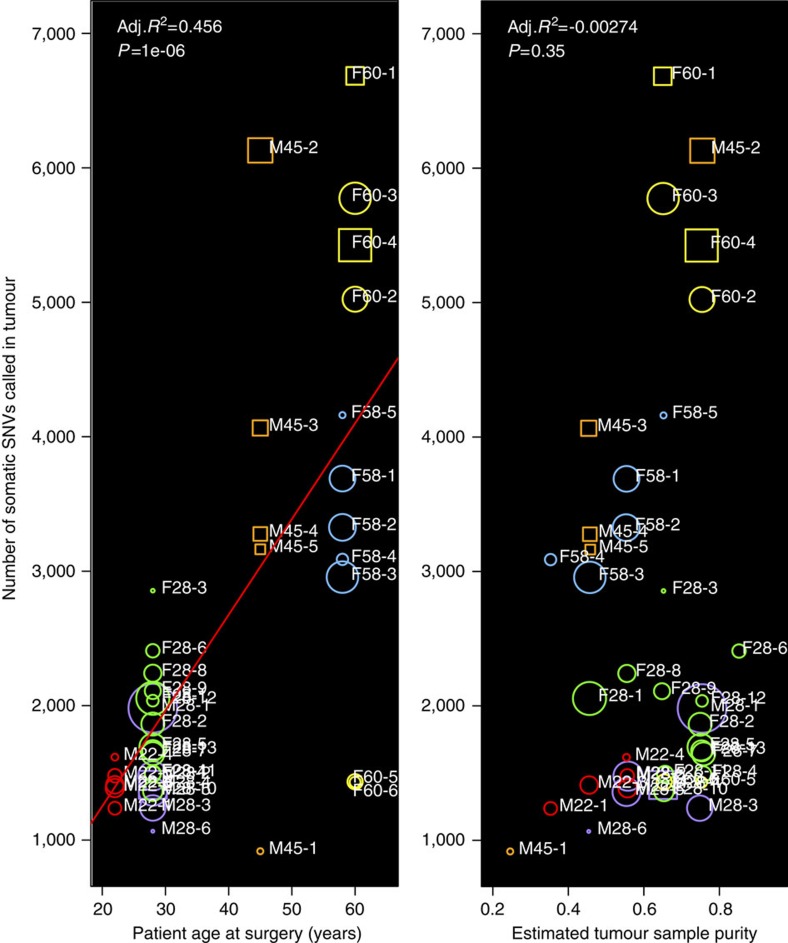
The number of somatic SNVs per tumour positively correlates with the patient's age at time of surgery.Colour indicates patient. Size indicates tumour size. Circles are Fuhrman grade 2, and squares are Fuhrman grade 3. The low outlier in patient M45orange was a small grade 2 tumour with lower purity, which could explain the reduced number of variants called. The low outliers in patient F60yellow, F60-5 and F60-6, both have low variant counts relative to the other tumours from that patient but neither were low purity.